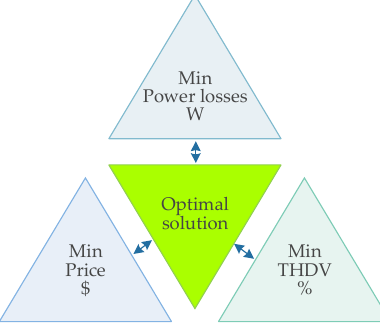
Figure 10. Schematic representation of trade-off method.